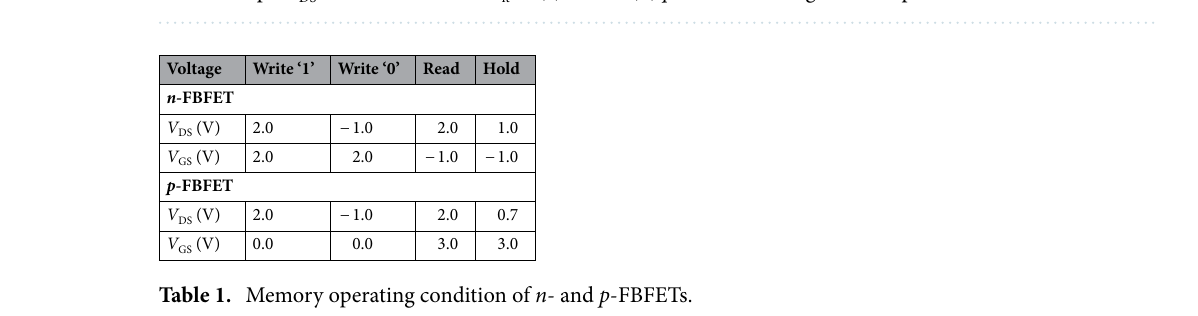
Figure 5c and d show the I DS values based on different N it at the interface of the n - and p -FBFETs, respec- tively, during read ‘1’ operation. For the read ‘1’ operation, as positive ITCs increase to N it = + 5 × 10 11 cm −2 , the I DS is lower in the n -FBFET, whereas the I DS is higher in the p -FBFET. In contrast, for the same operation, as negative ITCs increase to N it = − 5 × 10 11 cm −2 , the I DS level is higher in the n -FBFET, whereas the I DS is lower in the p -FBFET. The reason for the difference in the current values based on N it is that they affect the generation and elimination of the positive feedback loop. A high current value indicates that many charge carriers flow in the channel region. In addition, it indicates a low potential barrier height; thus, the memory window increases